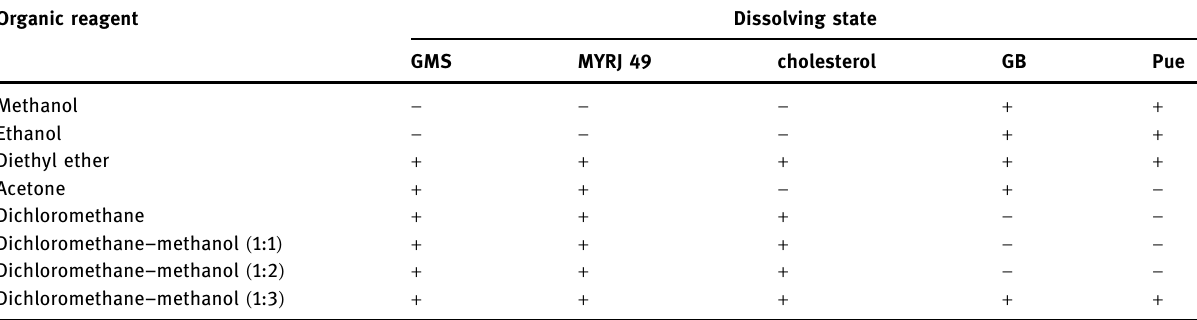
Table 2: Screening of organic solvents Organic